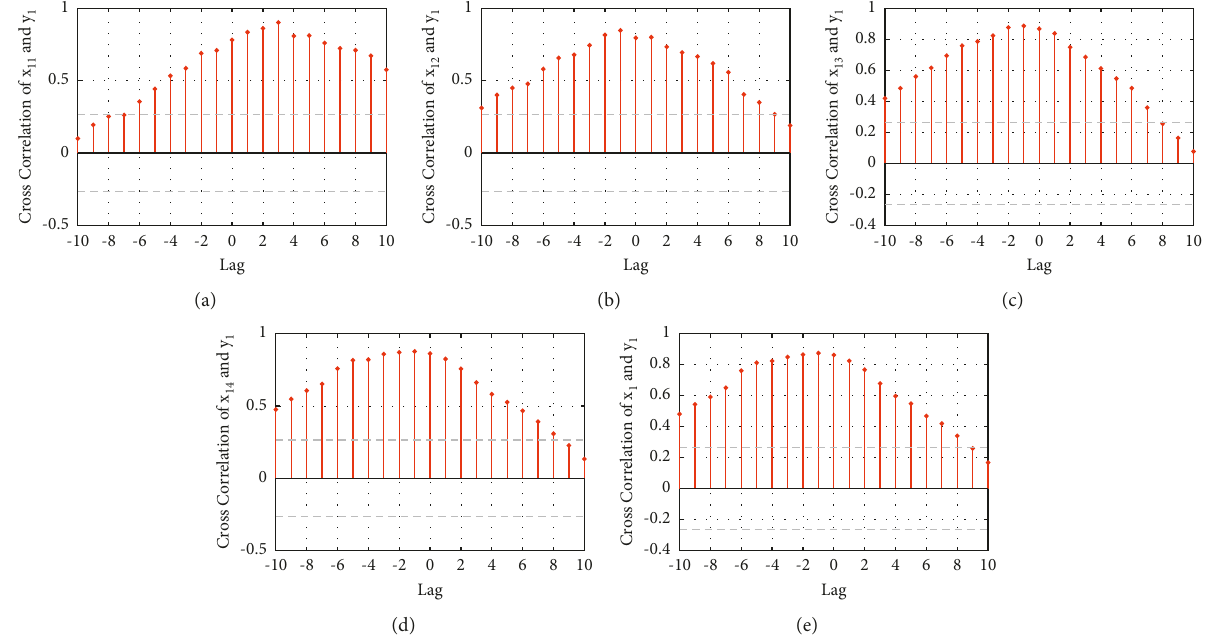
Figure 2: Cross-correlation coefficients between the number of daily confirmed cases of COVID-19 in Beijing from 20 January to 28 April, 2020, and the daily number of media reports of websites (a) xinhuanet.com, (b) huanqiu.com, (c) cnr.cn, and (d) news.sina.com.cn. (e) Cross-correlation coefficients between the average daily number of media reports and the number of daily confirmed cases.